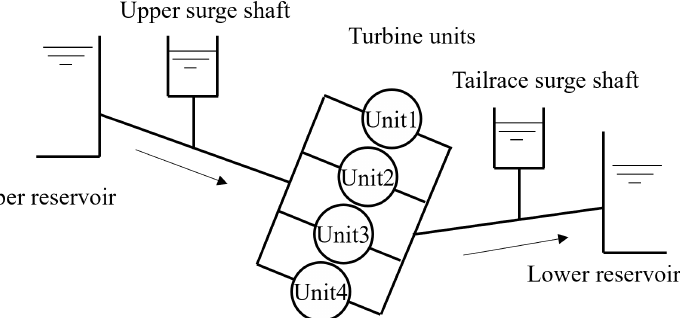
Figure 1. The layout of the pipeline system of the researched pumped storage power plant.